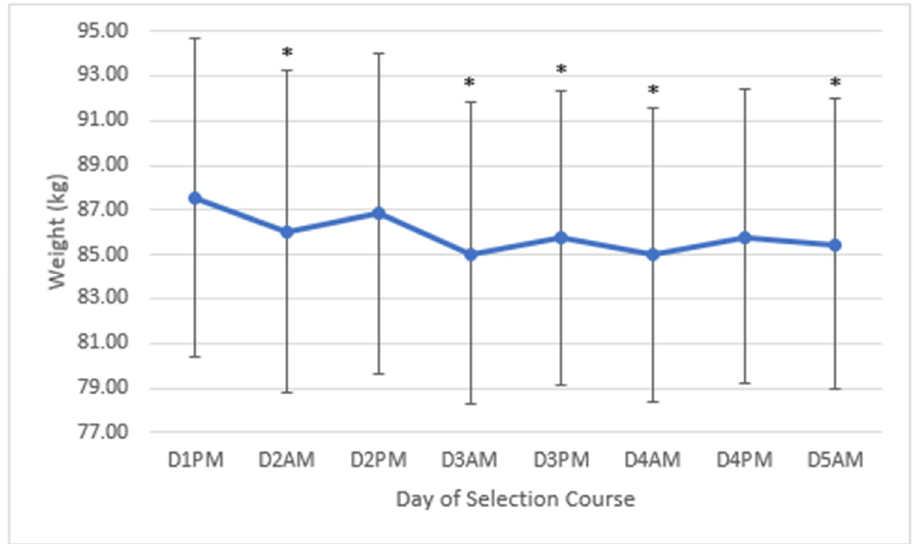
Figure 1. The group average changes in body mass (±SD) over the course of five days of morning (AM) and afternoon (PM) measurements. * = Significantly less than day one ( p < 0.05).